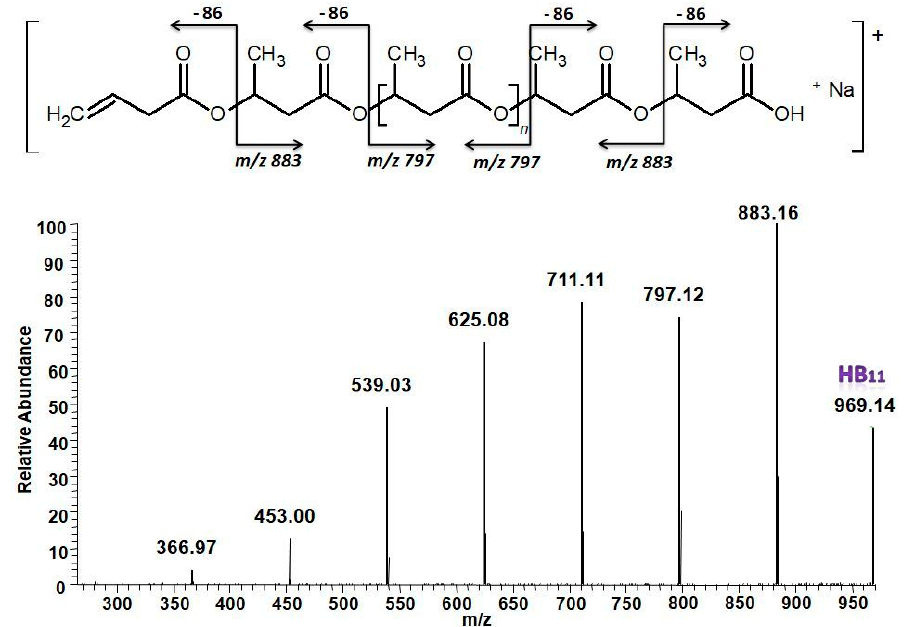
Figure 8. The ESI-MS / MS fragmentation spectrum of selected sodium adduct of [HB 11 + Na] + oligomers, at m/z 969 together with the theoretical fragmentation pattern.